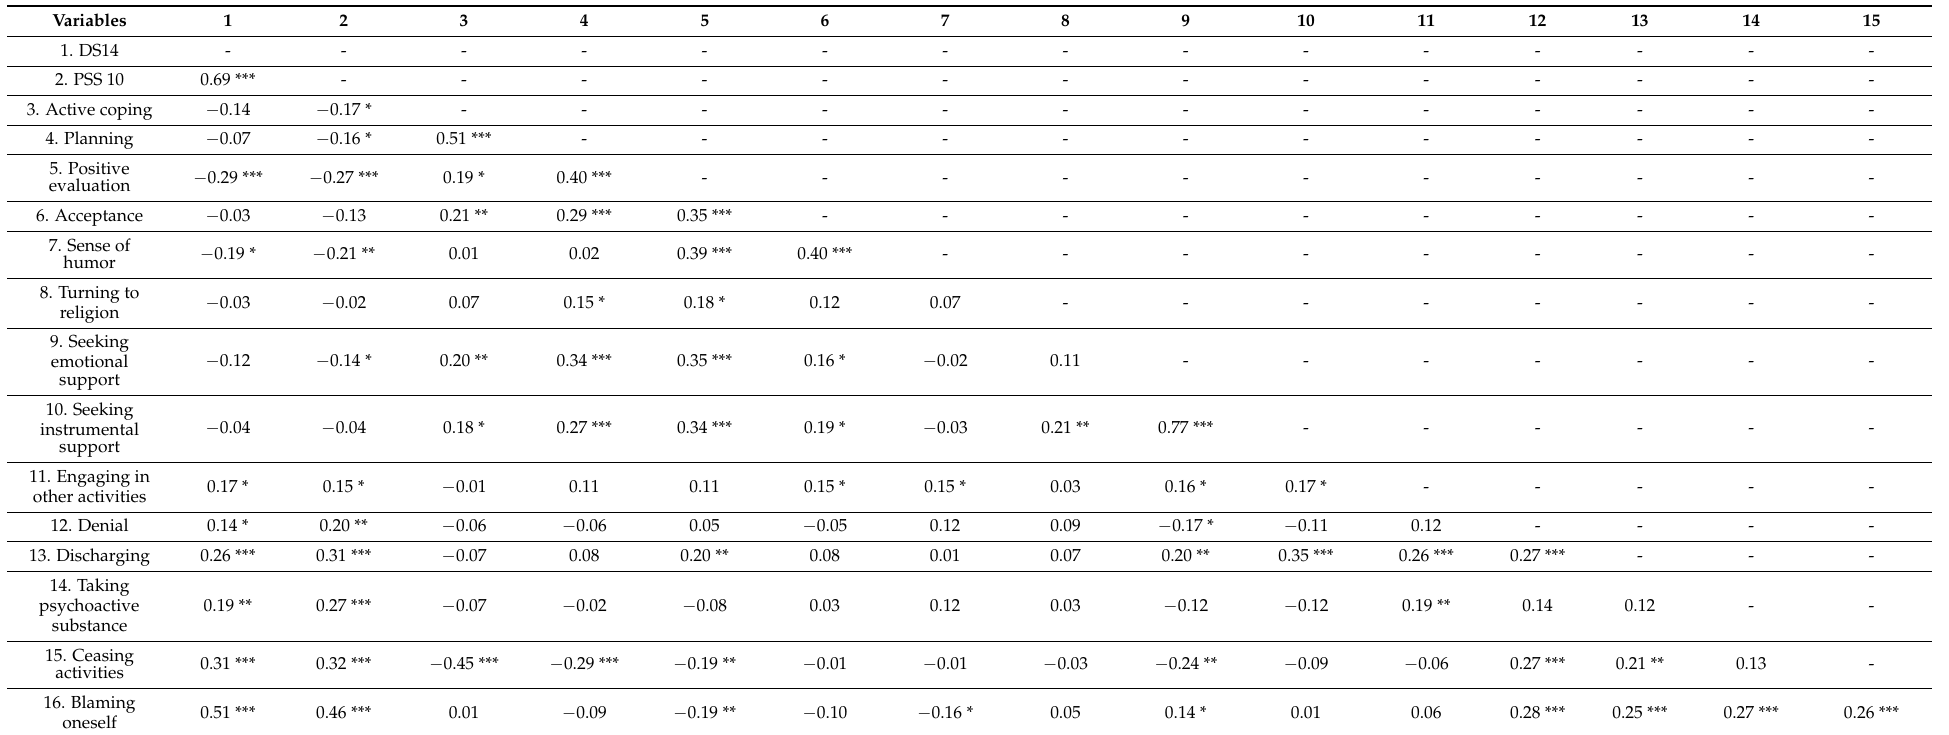
Table 6. Spearman’s correlation